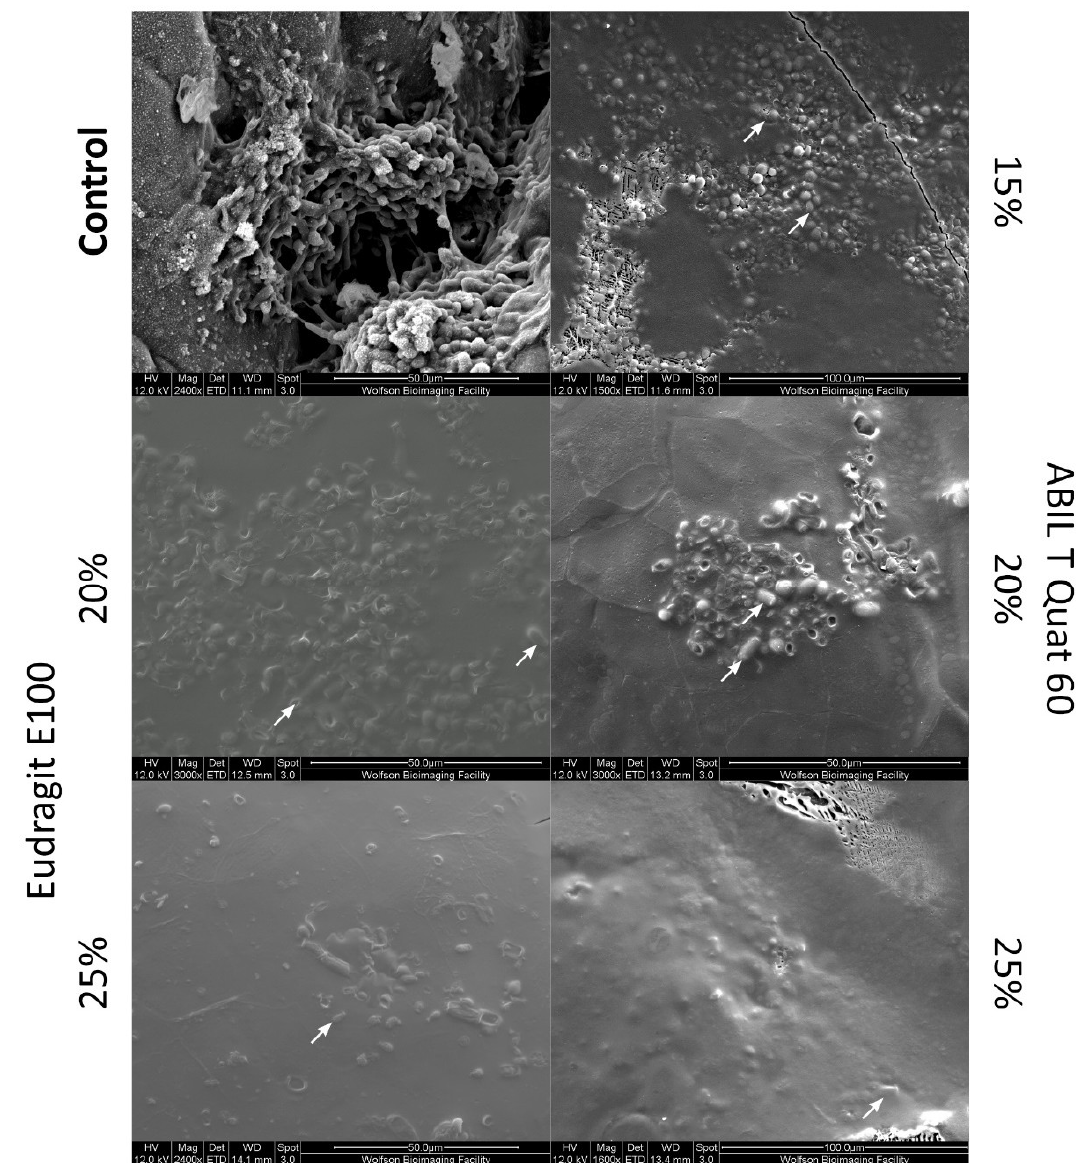
Figure 3. Cryo-SEM images of porcine skin pieces to which control solution (95% ethanol), or ethanol with ABIL (15–25%) or Eudragit (20–25%) were applied. This was followed by inoculation with T. rubrum conidia. After 24 h, conidia developing hyphae can be seen in the control, while a smooth surface was observed when polymers had been applied to the skin. The arrows indicate the positions of some of the conidia.